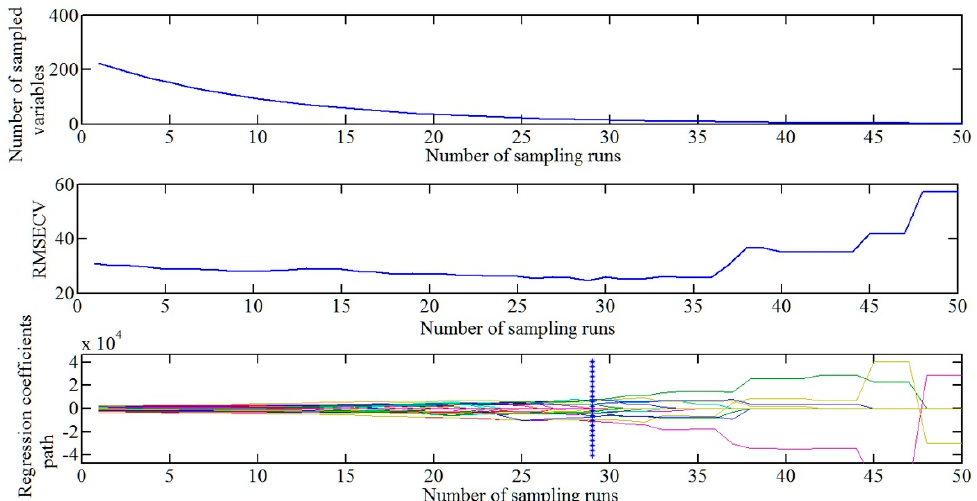
Figure 5. Changes of the number of sampled variables, RMSECV and regression coefficients path with the increase in the number of sampling.